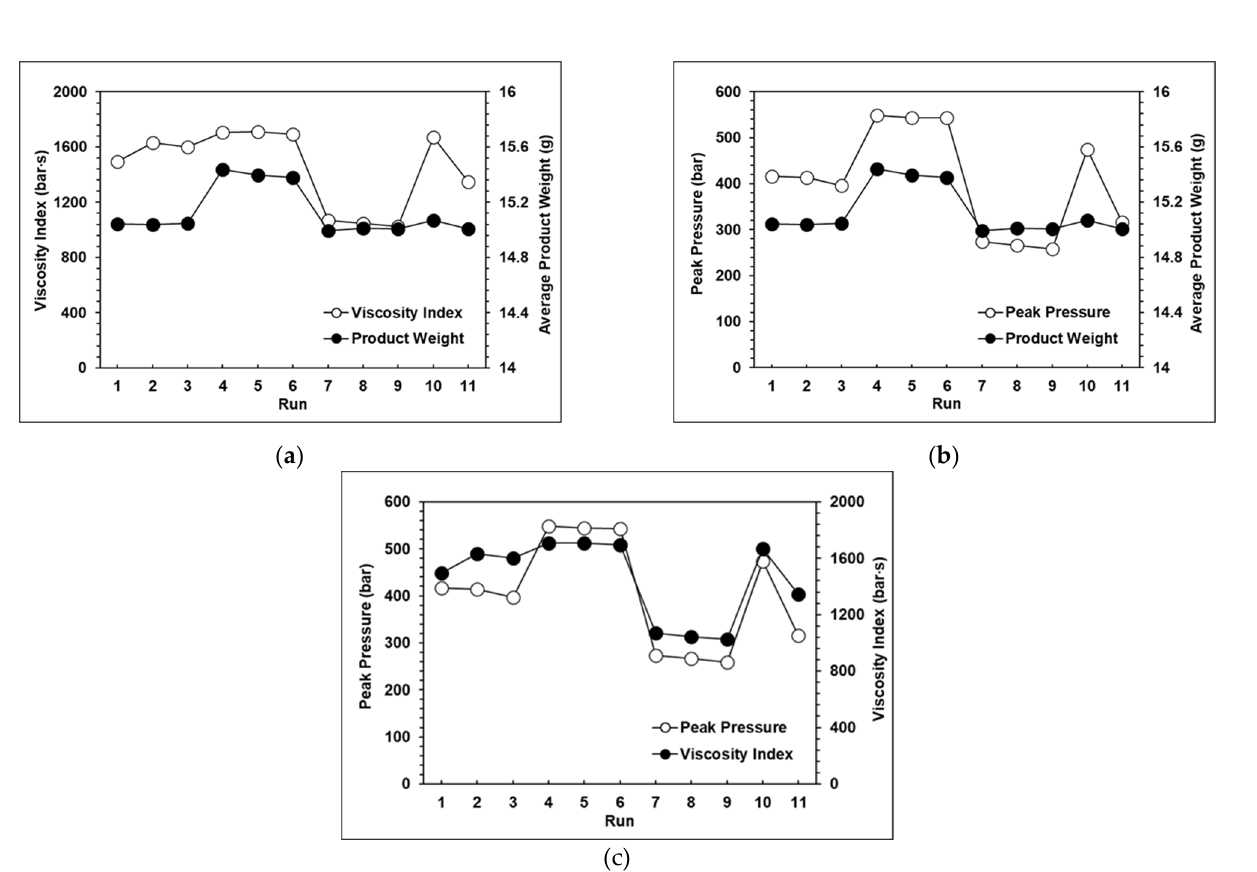
Figure 8. ( a ) Relationship between the product weight and the viscosity index with eight seconds of packing time; ( b ) Relationship between the product weight and peak pressure with eight seconds of packing time; ( c ) Relationship between the viscosity index and peak pressure with eight seconds of packing time.